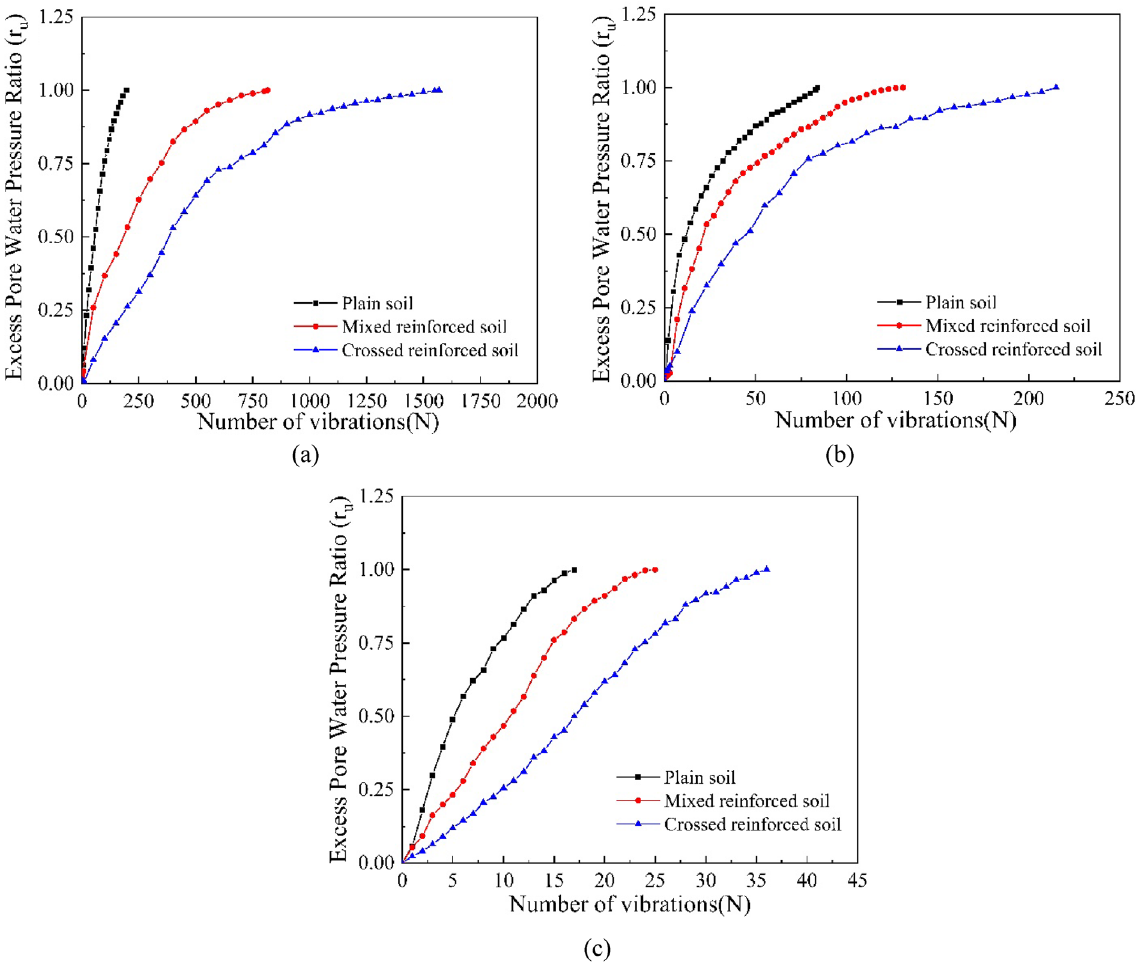
Figure 8. Pore water pressure ratio versus number of vibrations: ( a ) dynamic stress amplitude of 15 kPa, ( b ) dynamic stress amplitude of 20 kPa, and ( c ) dynamic stress amplitude of 25